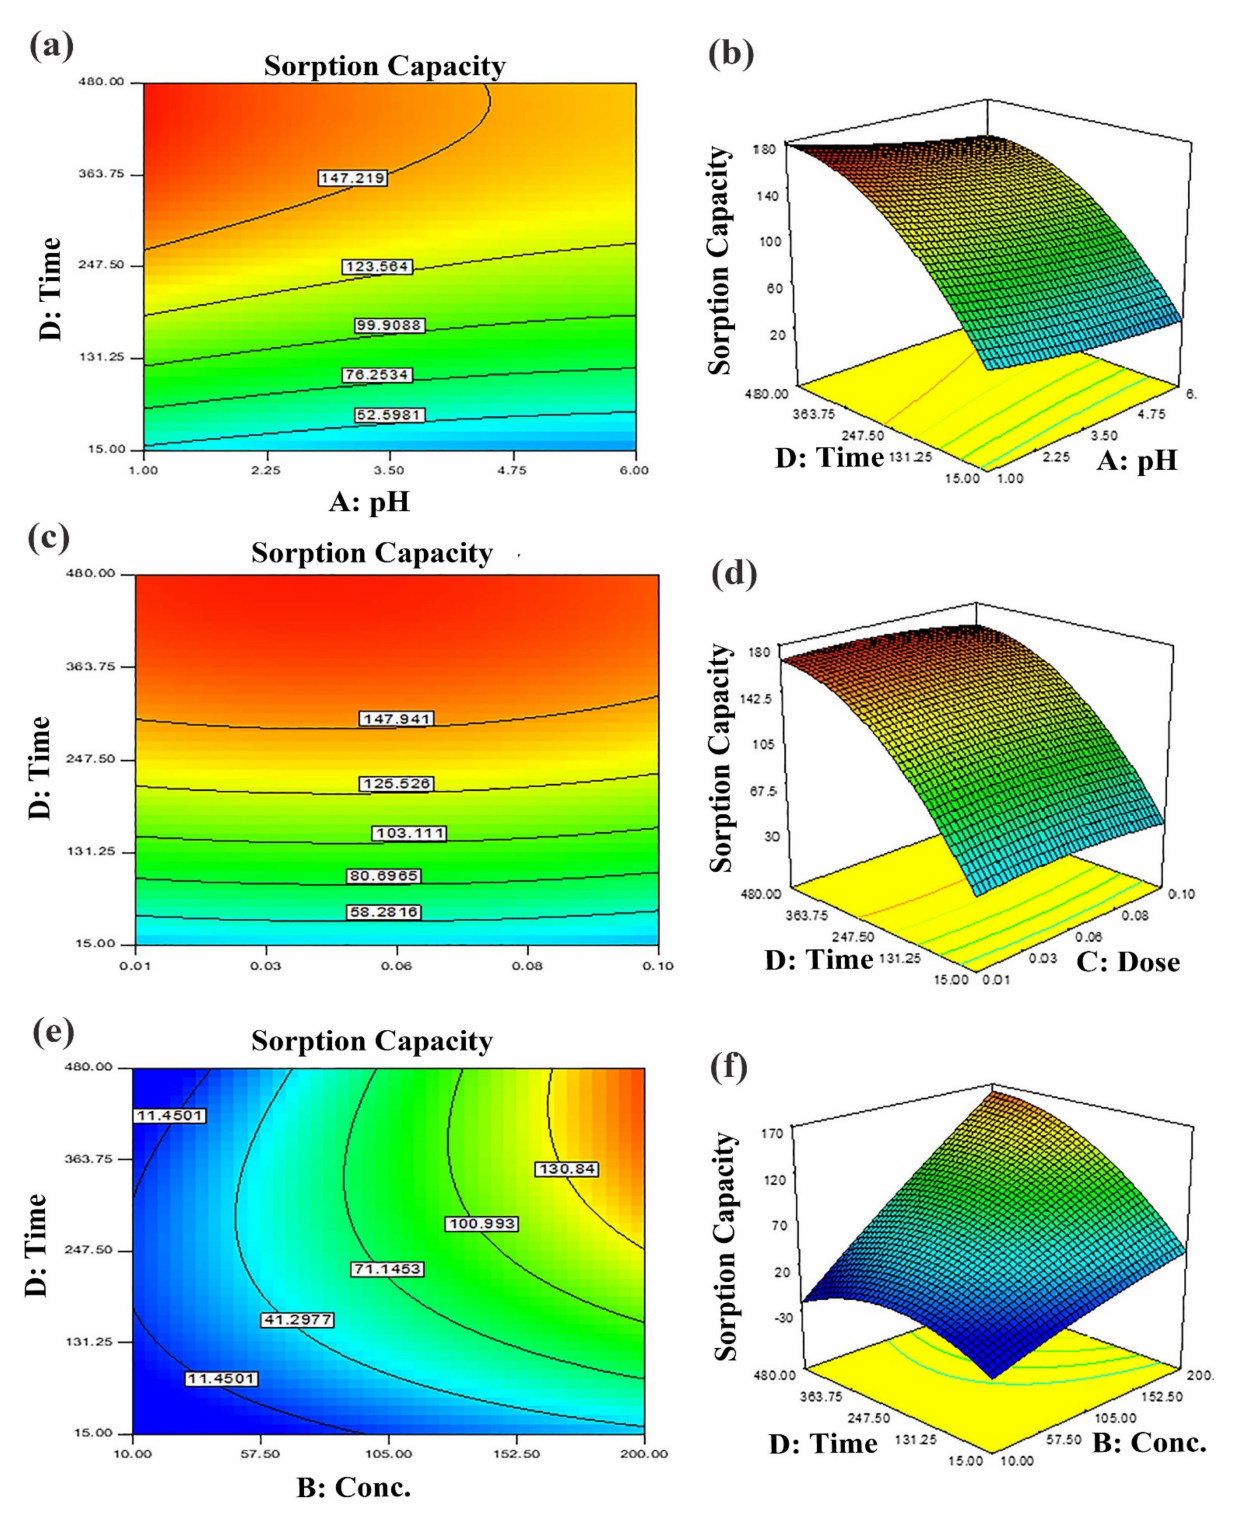
Figure 7. Predicted dye removal contour plots under influence of: ( a ) pH–contact time, ( b ) contact time–sorbent dose and ( c ) contact time–initial concentration and the related response surface plots in ( d – f ) at central point values of other